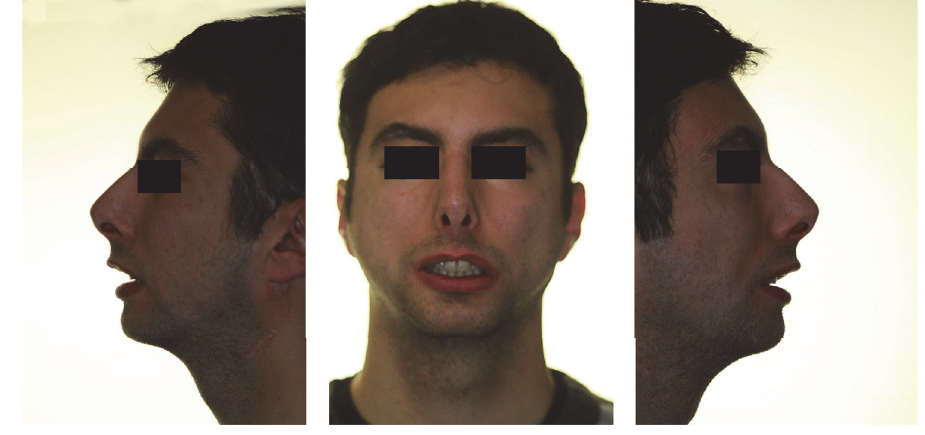
Figure 9: Profile after surgery.